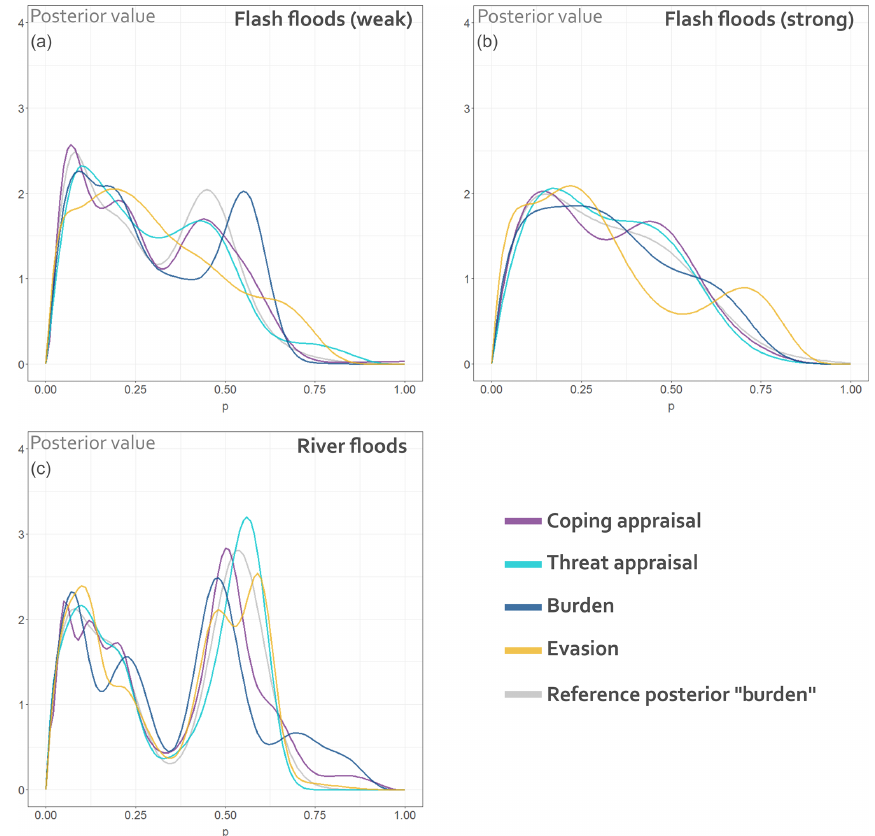
Figure 4. Weighted arithmetic mean of all posterior distributions for the psychological indicators coping appraisal, threat appraisal, burden and evasion, given weak flash floods (a) , strong flash floods (b) and river floods (c) . The reference posterior is shown for burden only.